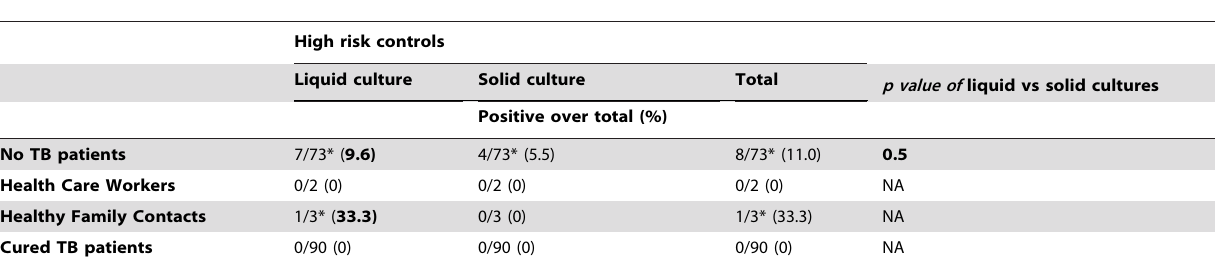
Table 11. Comparative frequency of positive results of liquid versus solid culture in the adult high-risk controls